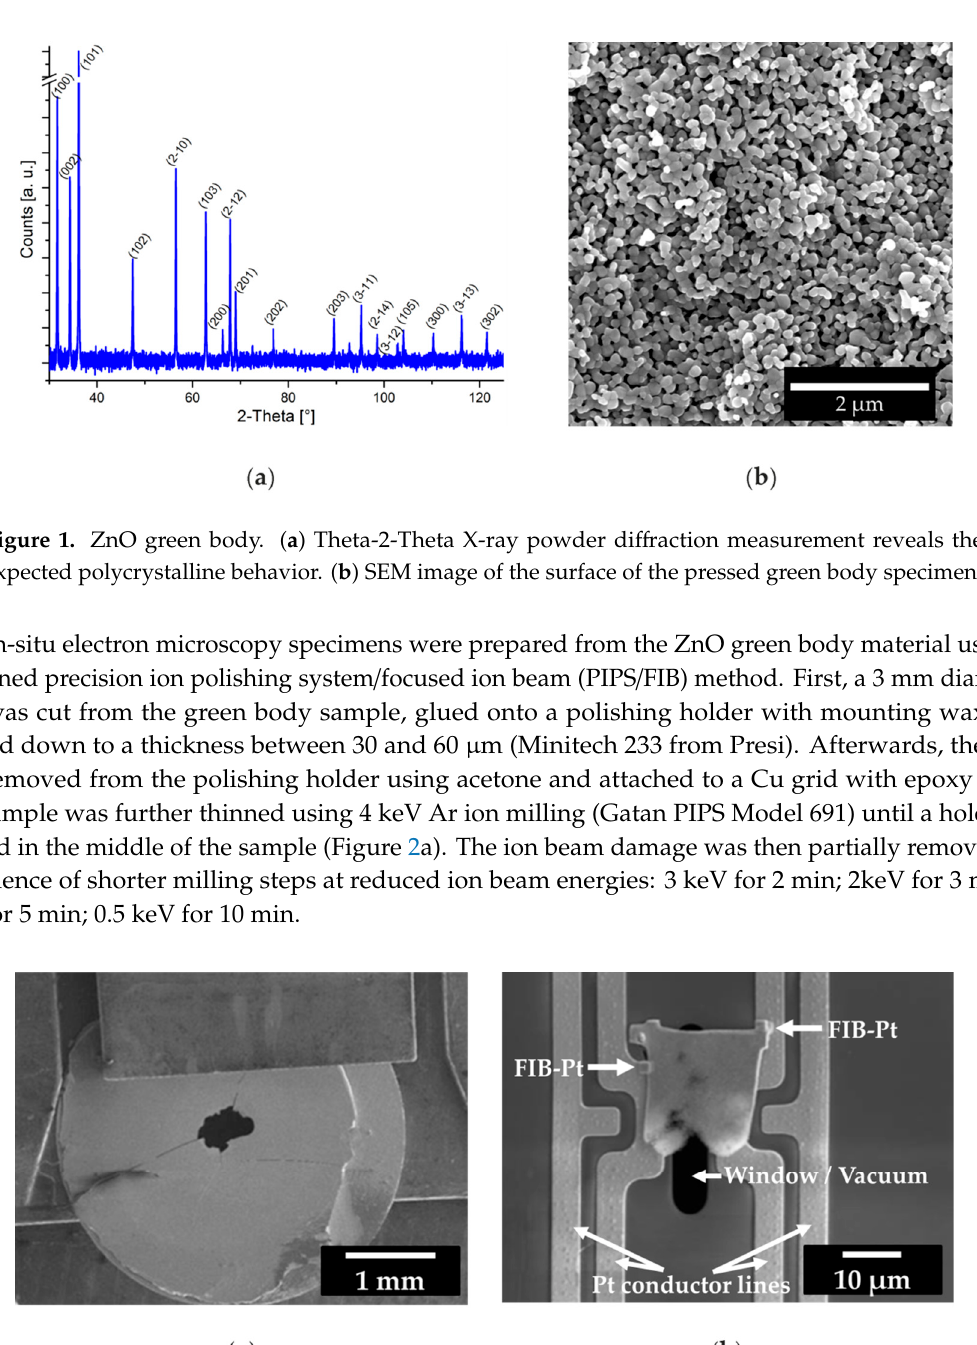
Figure 1. ZnO green body. ( a ) Theta-2-Theta X-ray powder diffraction measurement reveals the expected polycrystalline behavior. ( b ) SEM image of the surface of the pressed green body specimen.